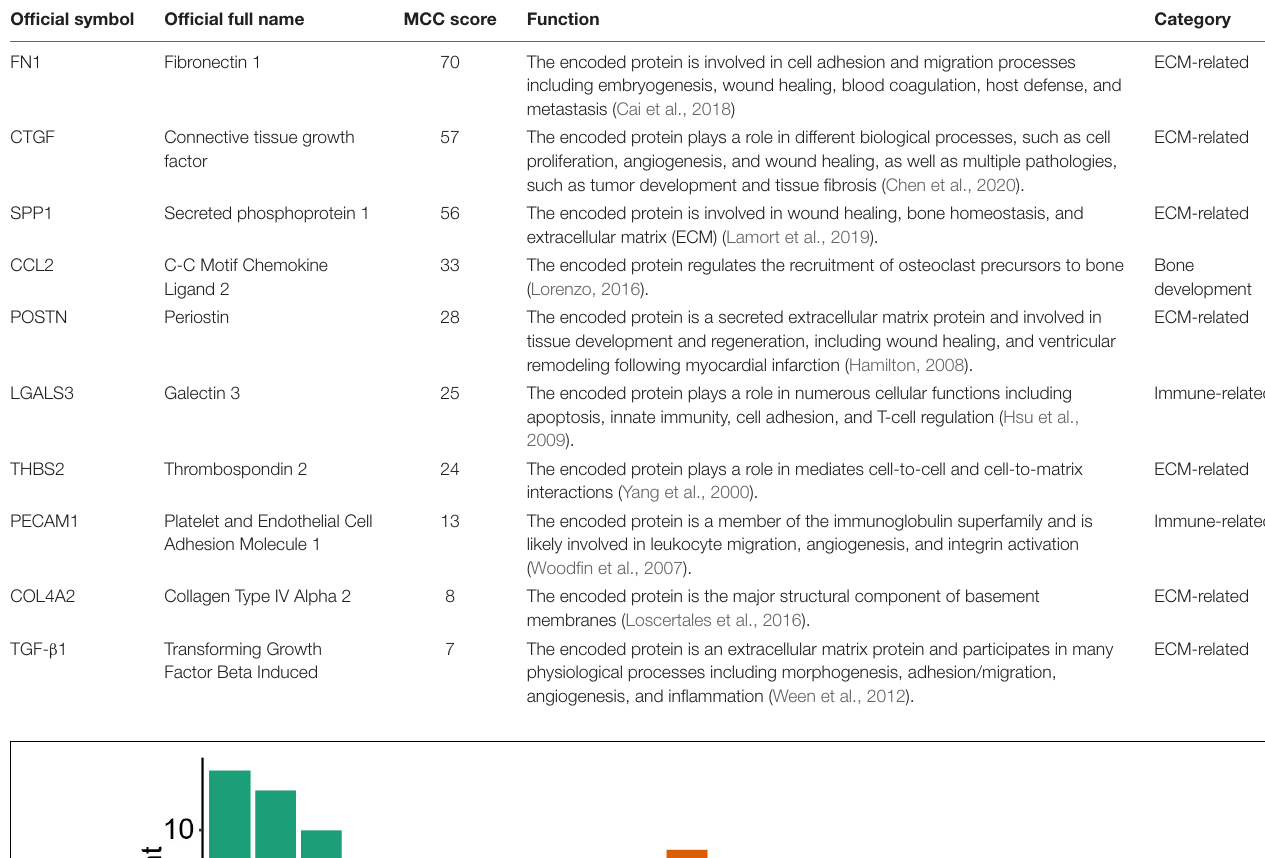
TABLE 4 | Hub genes selected by Maximal Clique Centrality (MCC) score.